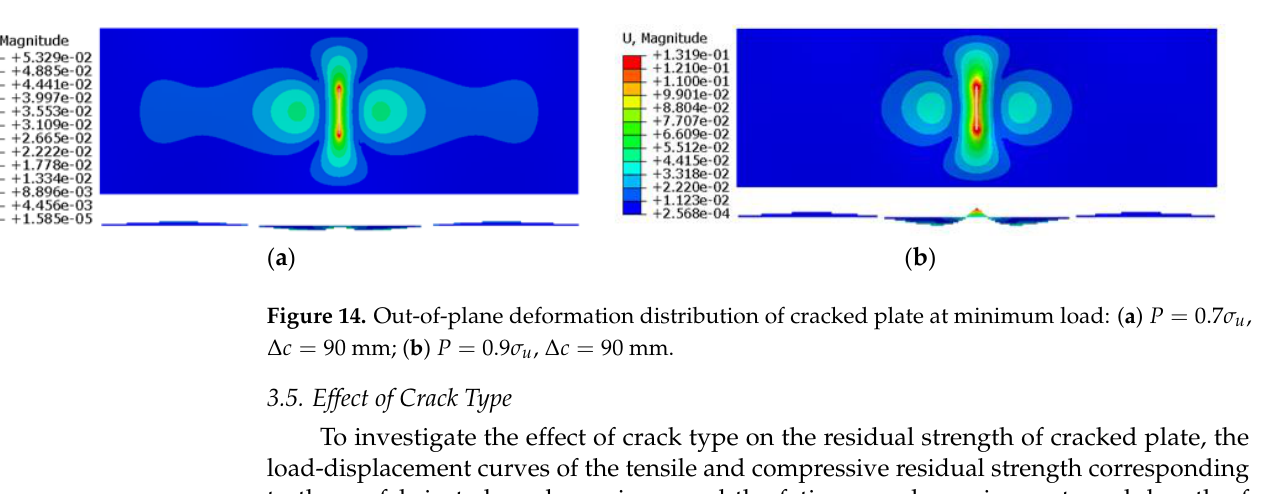
( b ) Figure 15. Load-displacement curves of plate with prefabricated crack and fatigue crack at 2𝑐/𝑏 = 0.3 : ( a ) Compressive residual strength; ( b ) Tensile residual strength In addition, the stress distribution and out-of-plane deformation of the prefabricated crack model when it reaches the limit state are also similar to the crack formed by crack propagation, as shown in Figures 16 and 17. Therefore, from the above analysis, it can be seen that crack propagation has little impact on the residual strength assessment of cracked plates.